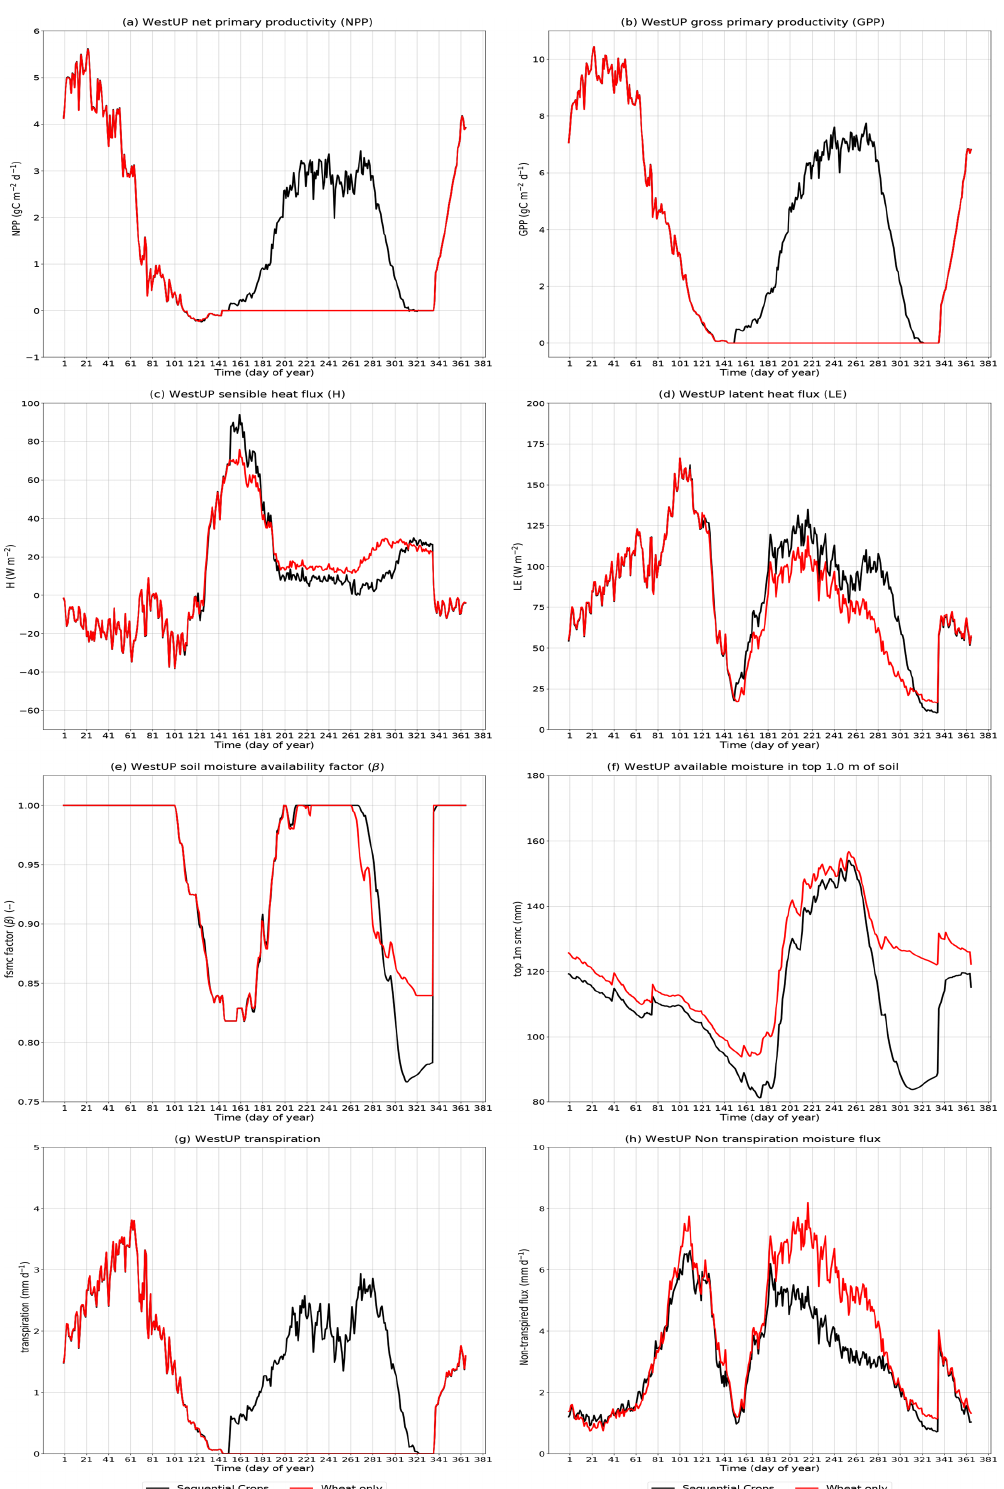
Figure 7. Annual climatology of fluxes (in day of year) for WestUP for India-sequential (black) and India-single (red): carbon fluxes: NPP (a) and GPP (b) . Heat fluxes: sensible heat H (c) and latent heat LE (d) . Soil moisture variables: β (e) and soil moisture availability in the top 1m of soil (f) . Moisture fluxes: evapotranspiration (g) and non-evapotranspiration moisture fluxes (h) .